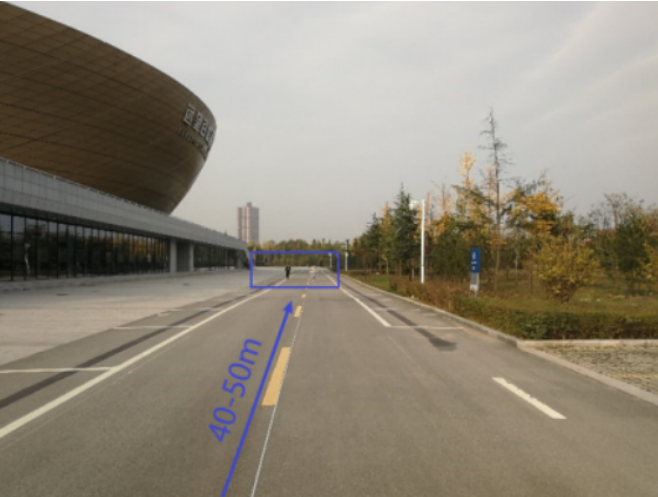
Figure 17. Additional experiments for pedestrian